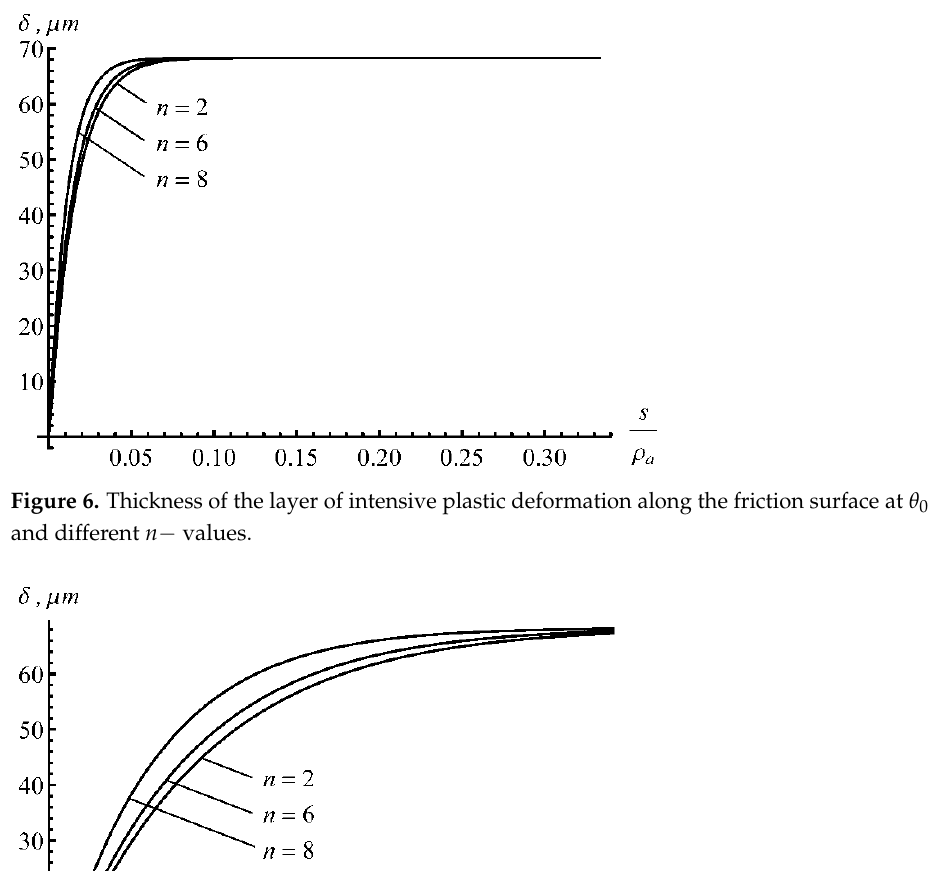
30 o 30 o 30 o 0 0 0